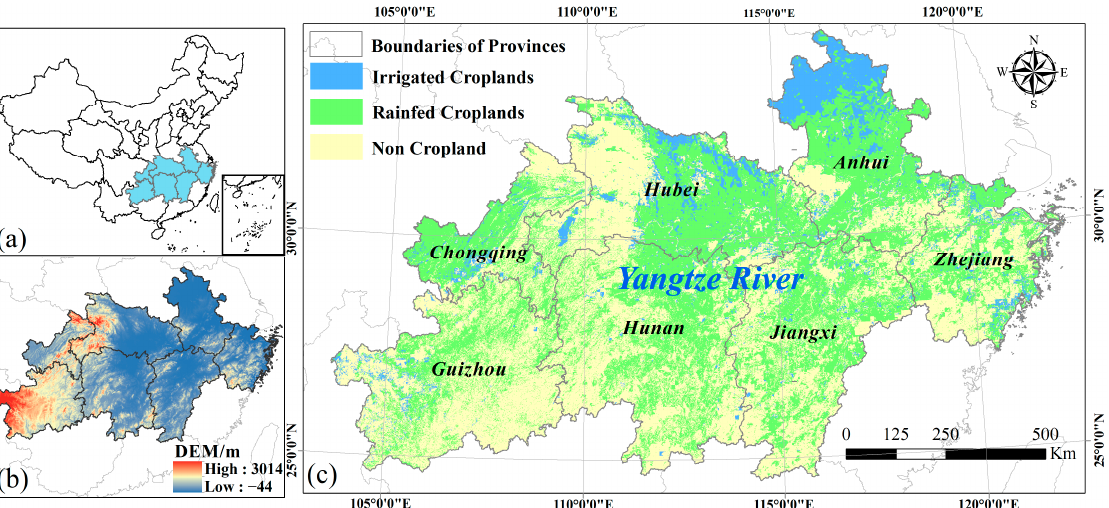
Figure 1. The cropland types and elevation of the middle and lower reaches of the Yangtze River in China. ( a ) Location of the study area in China. ( b ) Digital elevation model map of the study area. ( c ) Irrigated and rainfed croplands map of the study area.